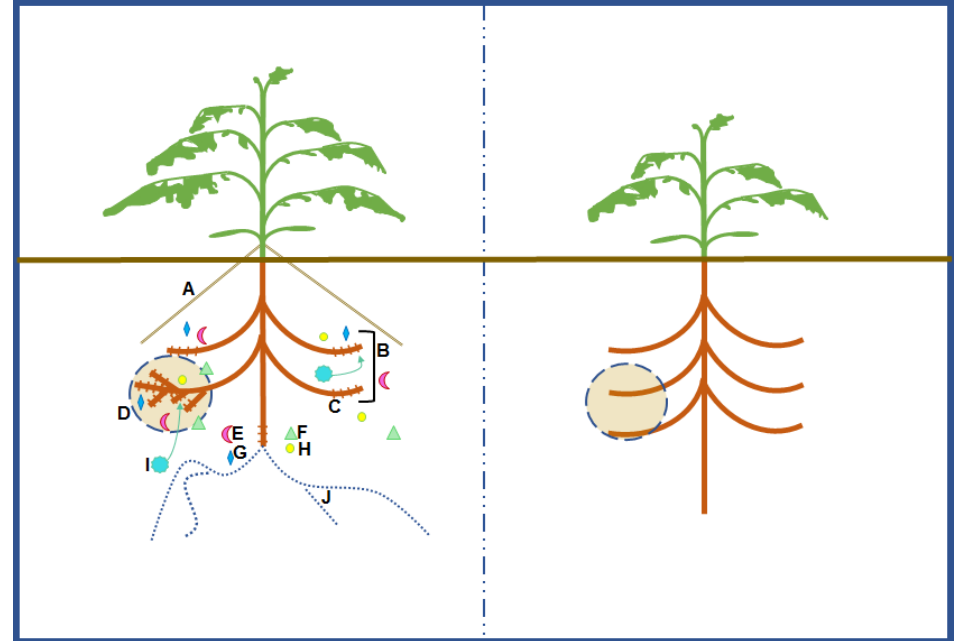
Figure 1. A tomato plant efficient in phosphorus (P) acquisition. A hypothetical tomato adapted